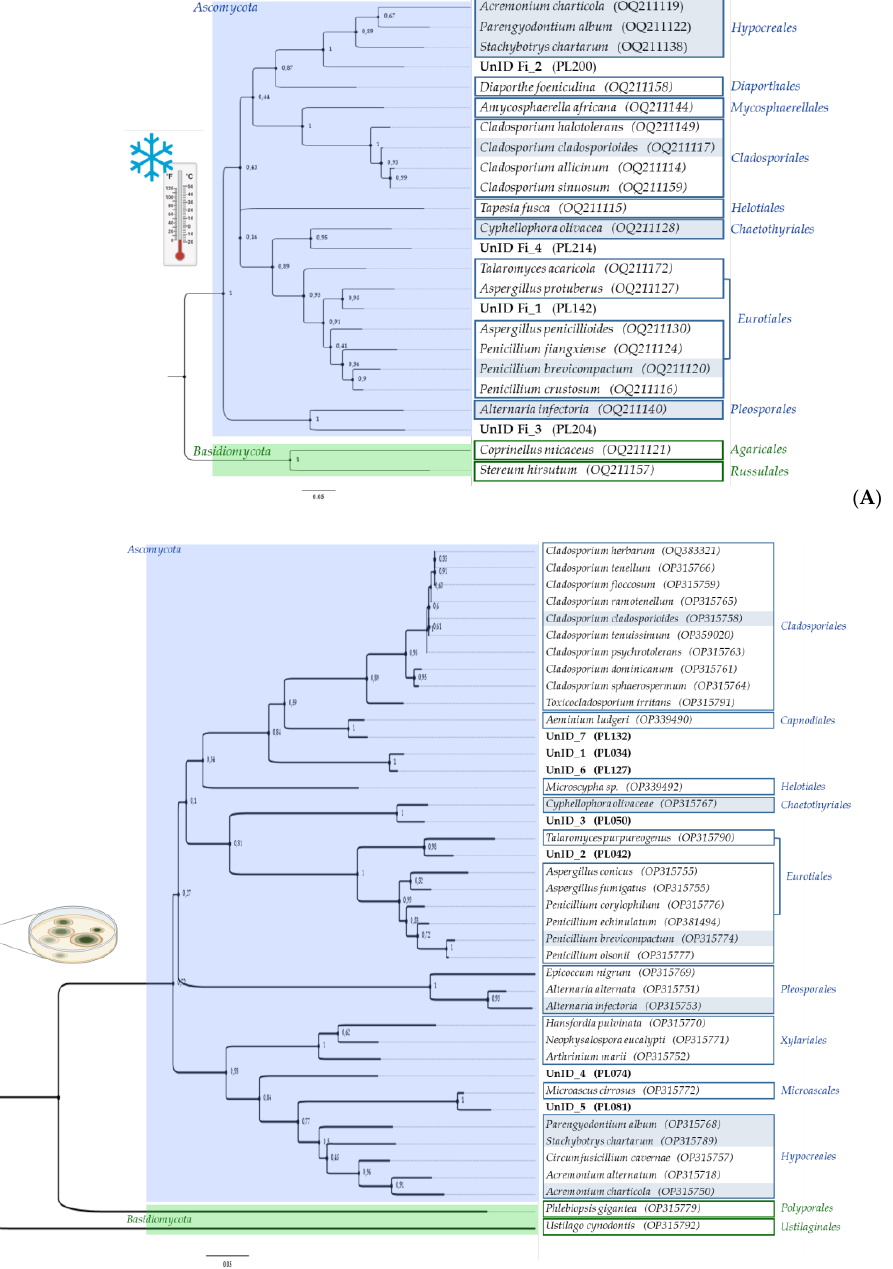
Figure 5. Phylogenetic trees (generated using maximum likelihood with the Kimura two-parameters model using a Gamma distribution (+G)) showing the genetic diversity among the ITS rDNA sequences of isolated fungi, obtained from: ( A ) standard freezing incubation; and ( B ) direct plating.